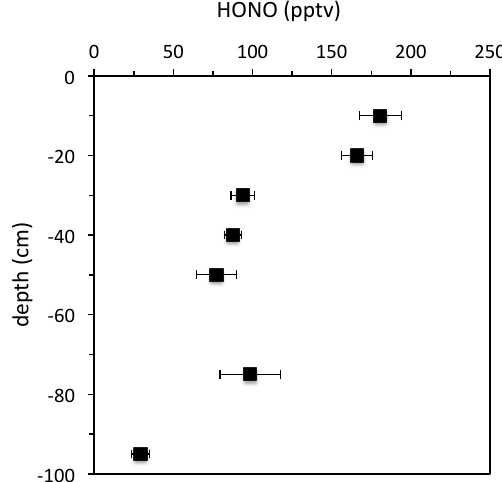
Figure 4. Firn air mixing ratios of HONO down to 1m depth mea- sured at DC at 13 January